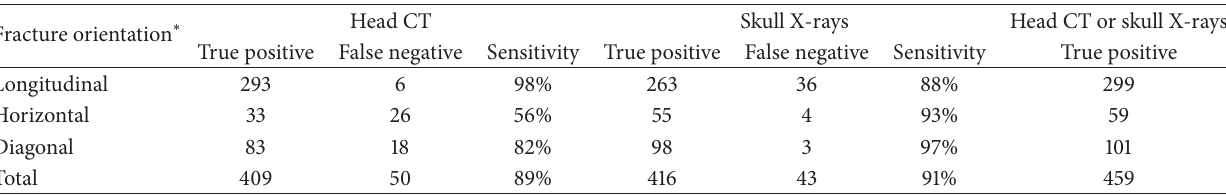
Table 1: Numbers of linear skull fractures and sensitivities of head CT with 10 mm thick slices and skull X-rays (anteroposterior, lateral, and Towne views).